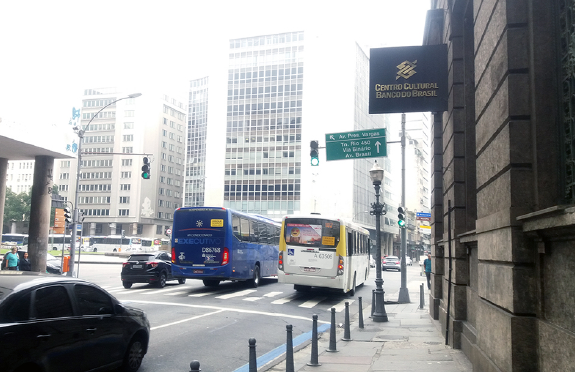
Figure 4: Primeiro de Março av. crossing Presidente Vargas, near to Candelária Cathedral before pandemic (close to measuring location